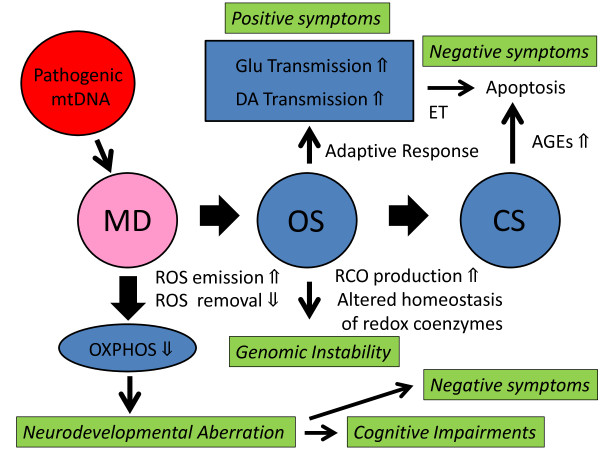
Proposed pathophysiology of schizophrenia. Mitochondrial dysfunction (MD), through imbalance of ROS production and removal, raises ROS emission, causing a strong intracellular OS. Disturbed OXPHOS and enhanced OS in predisposed individuals may cause various pathogenic alterations such as genomic instability, aberrations in neuromuscular development, brain dysfunction, and apoptosis. On the other hand, enhanced OS and secondarily induced alteration of redox coenzyme homeostasis may cause enhanced CS. It is assumed that the brain has the third class of antioxidant defenses in which neurotransmissions are involved, and that trans-synaptic activation of NMDA-R as well as DA-R may occur, through unknown pre-synaptic redox regulation mechanisms, as an adaptive response to OS which could not be suppressed by the class I (non-enzymatic) and II (enzymatic) defenses. Failure to suppress OS by those three classes of antioxidant defenses may lead to persistent strong OS and, through suppressing the expression of inhibitory interneurons, may cause prolonged excessive glutamate and/or DA release, leading to excitation toxicity (ET) and additional deterioration of the brain function.